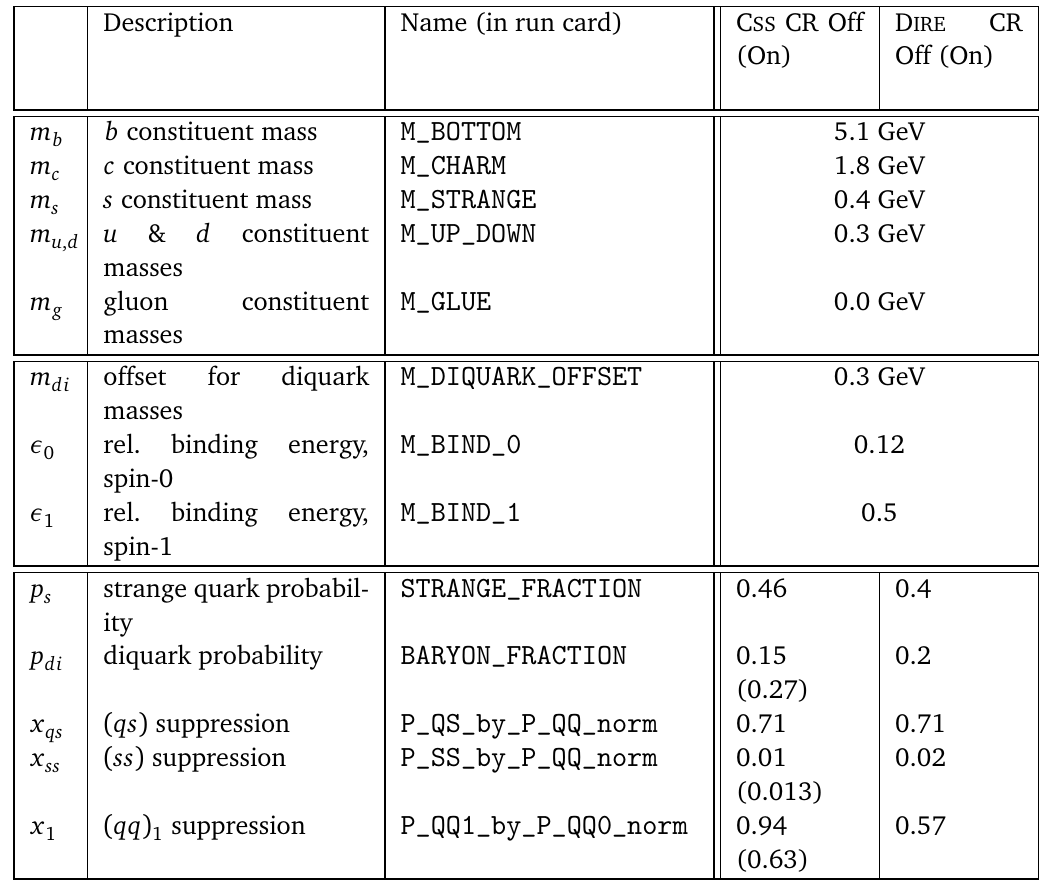
Table 3: (Fixed) non-perturbative input parameters for constituents: quark masses and parameters to calculate the diquark masses. Tuned popping probabilities for their non-perturbative production in gluon and cluster